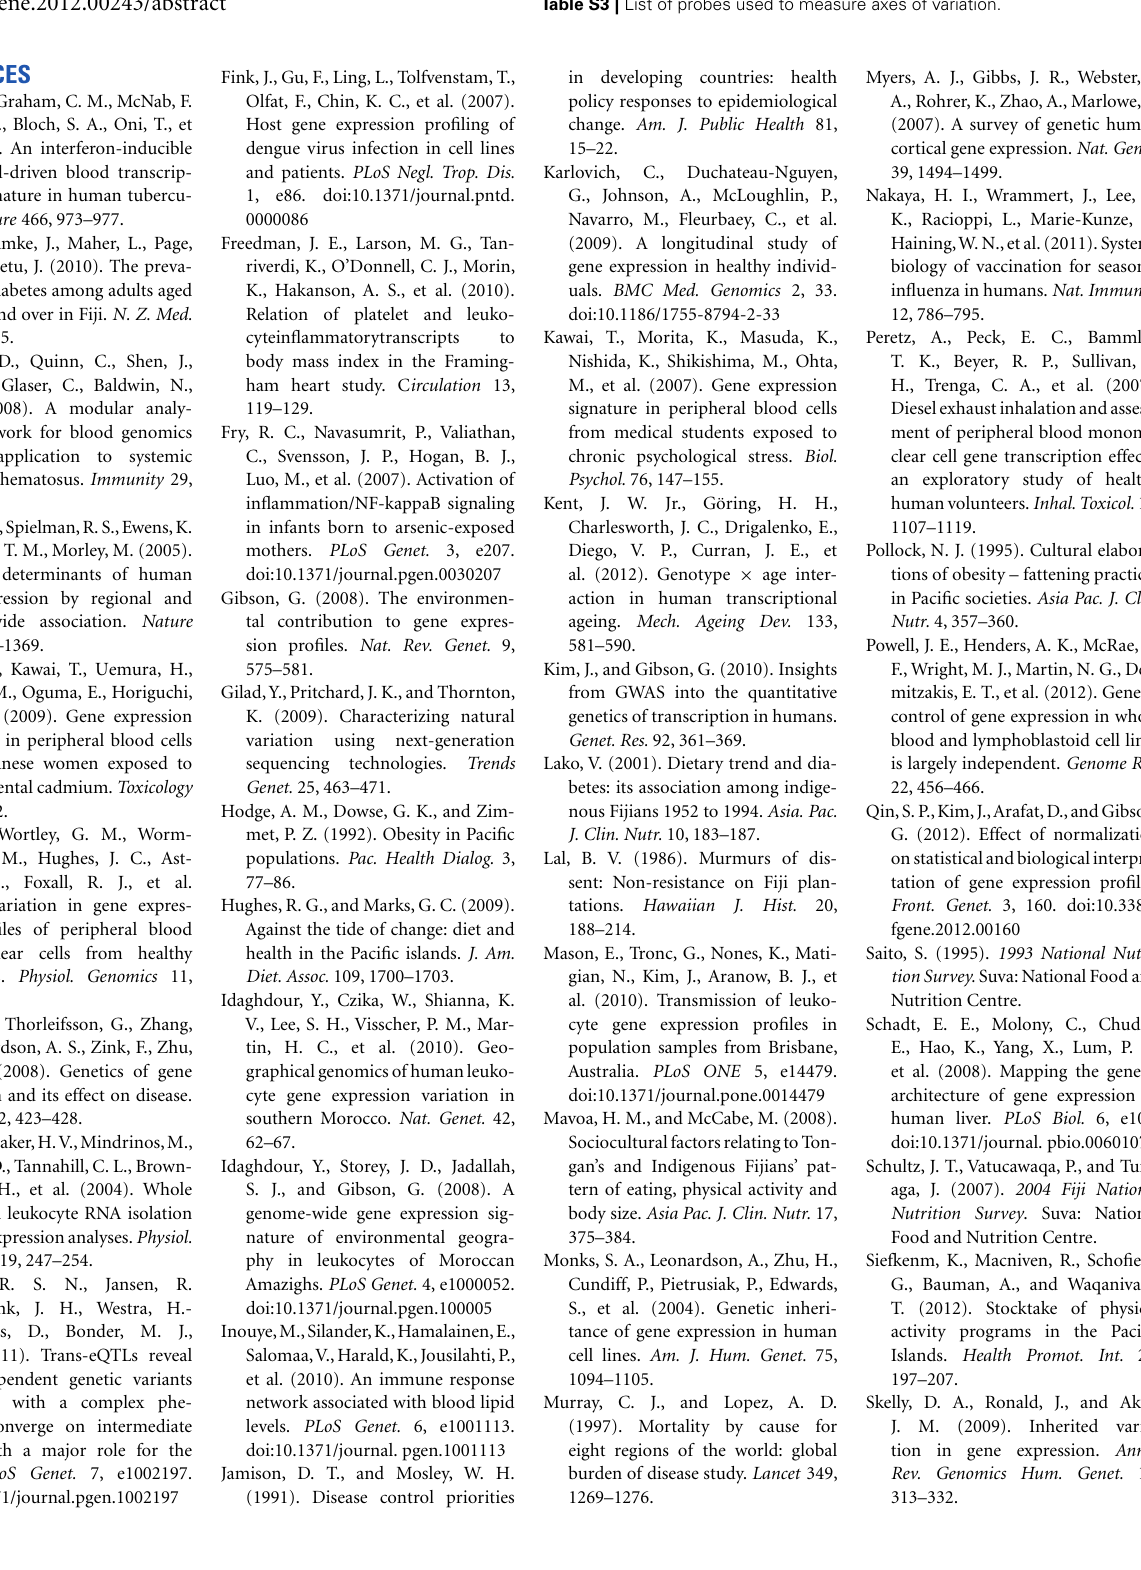
Table S1 | Raw and transformed illumina and fluidigm data. Table S2 | Experimental design files. Table S3 | List of probes used to measure axes of